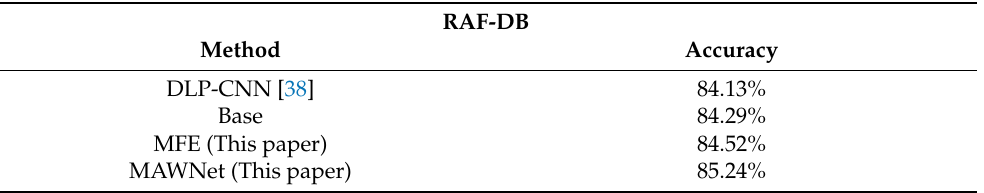
Table 5. Accuracy of different methods on the RAF-DB